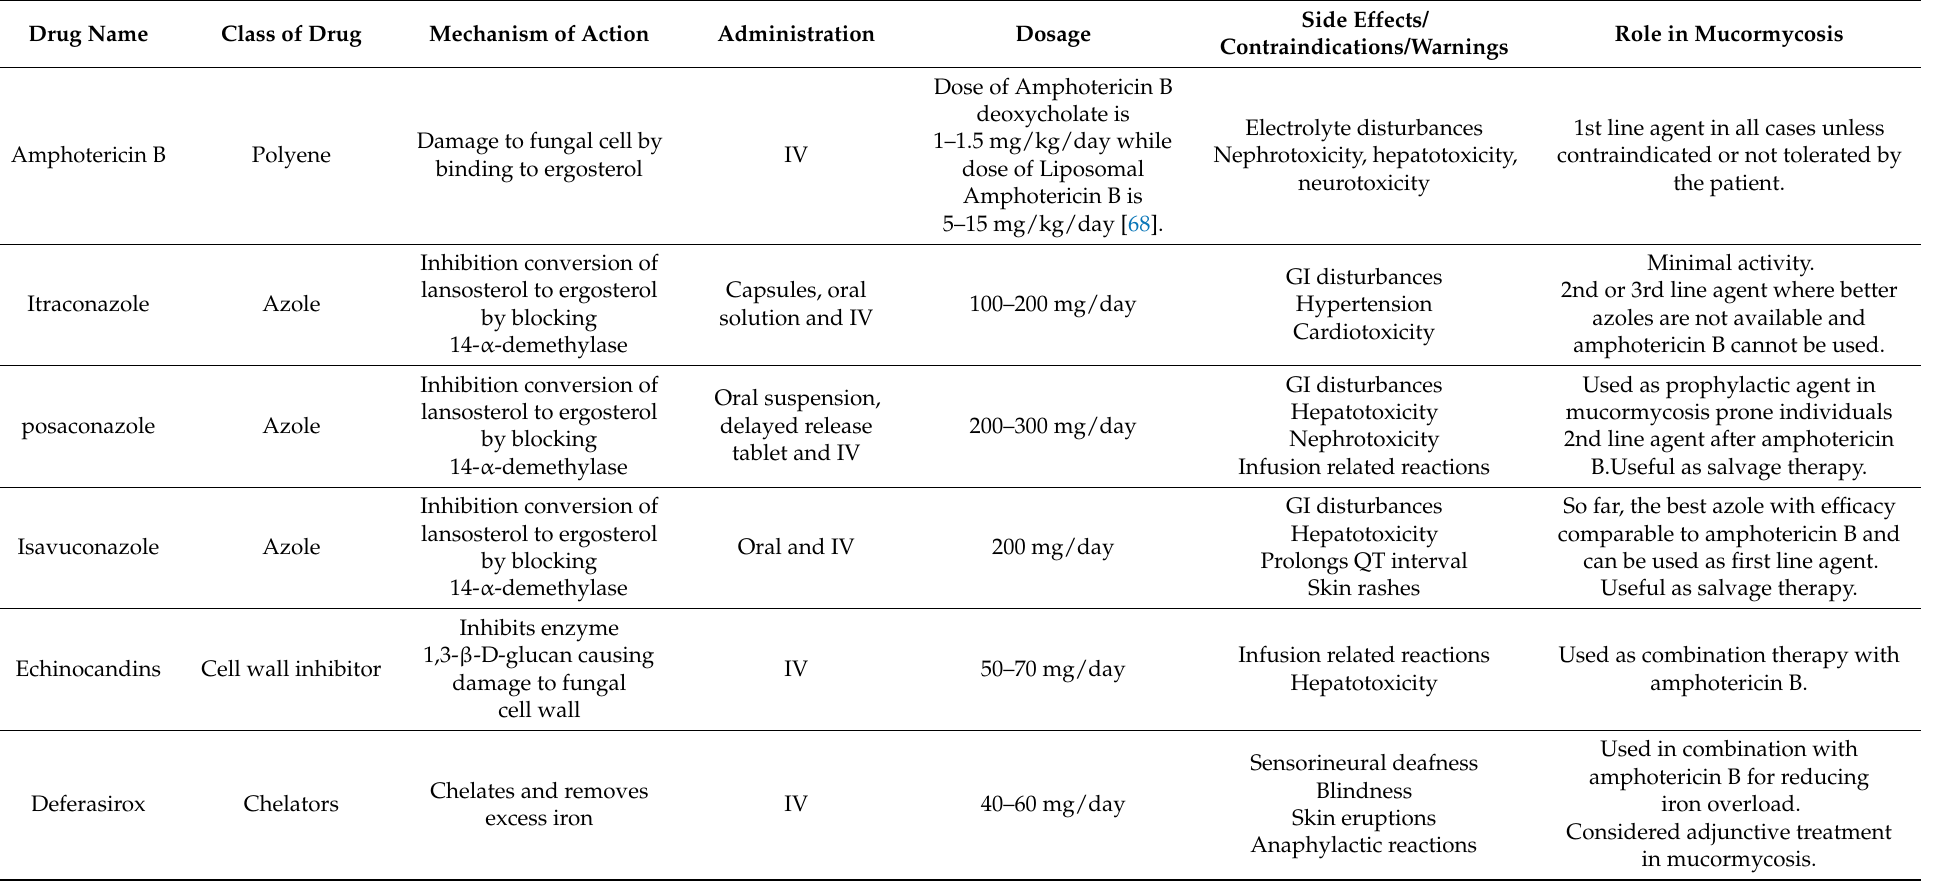
Table 4. Summary of medicinal management of